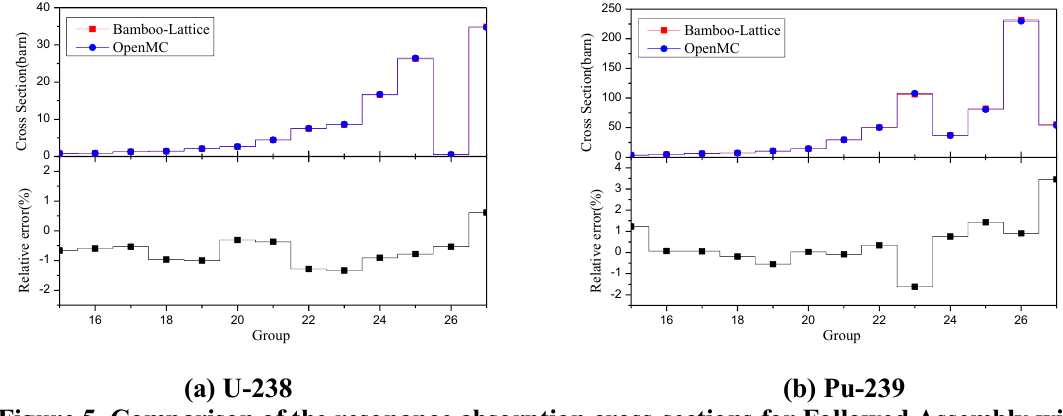
Figure 5. Comparison of the resonance absorption cross-sections for Followed Assembly with